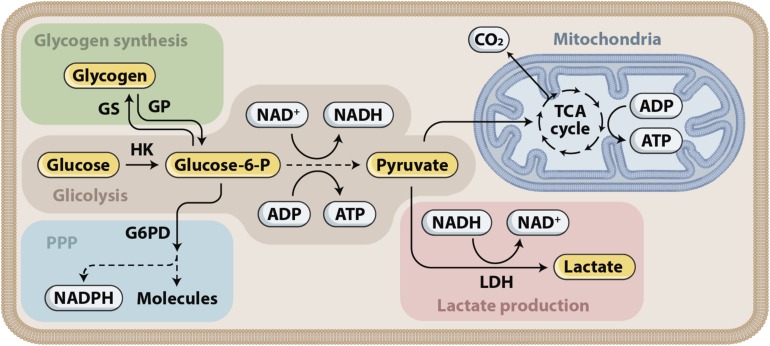
Glucose metabolism. Glucose is first phosphorylated to glucose-6-phosphate (glucose-6-P), which has three fates that correspond to the three main functions of glucose. First, energy can be stored as glycogen. Glycogen can later be mobilized and subsequently metabolized to pyruvate. Second, energy in the form of ATP can be produced by glucose-6-P entering glycolysis, supplying pyruvate for the tricarboxylic acid (TCA) cycle in the mitochondria and the associated oxidative phosphorylation. Glycolysis produces ATP and NADH. Depending on the cell type, pyruvate can also be converted into lactate through the action of lactate dehydrogenase (LDH). Third, reducing equivalents in the form of NADPH are produced in the pentose phosphate pathway (PPP).